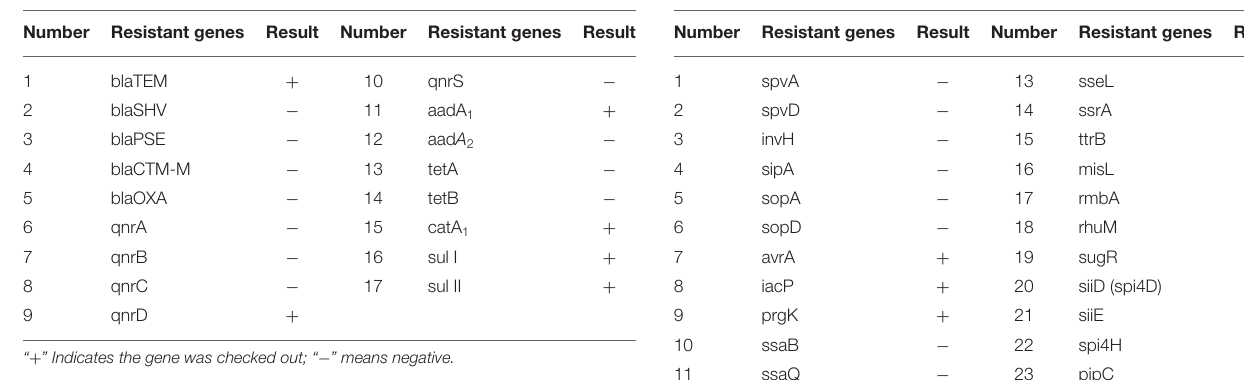
TABLE 5 | The positive detection of drug-resistant genes. TABLE 6 | The positive detection of virulence genes.